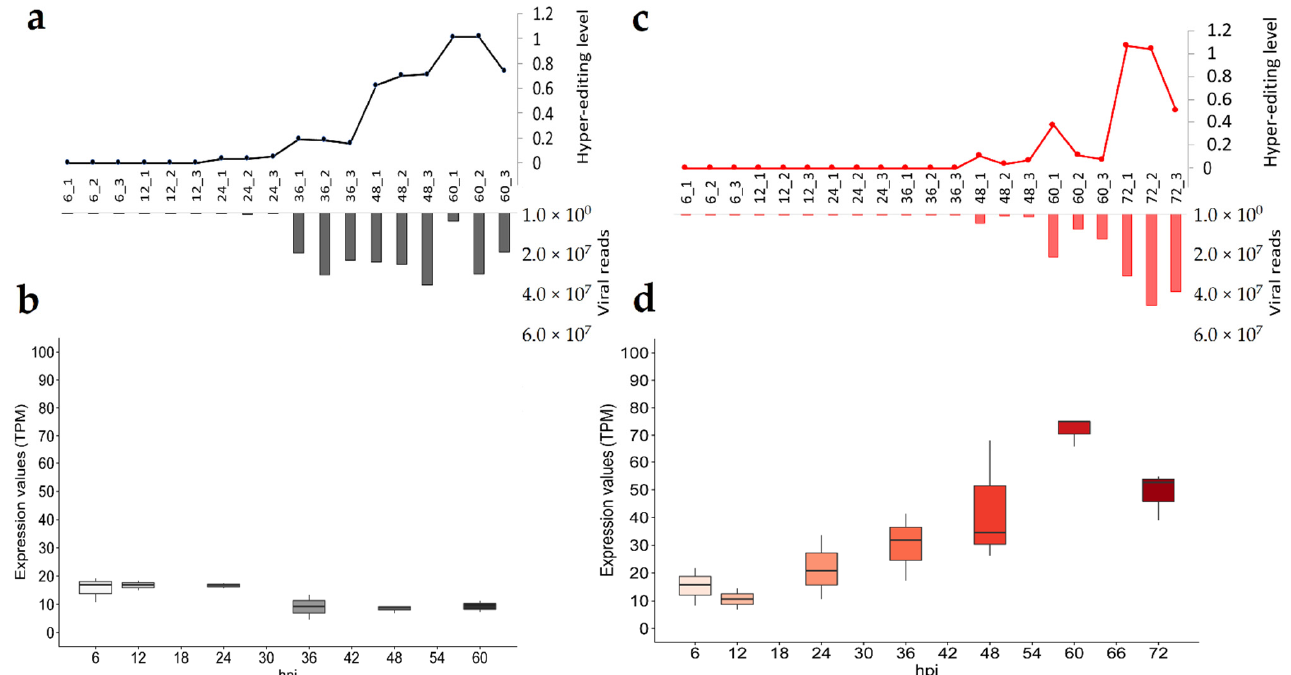
Figure 4. ADAR1 activity and expression levels during malacoherpesvirus infection. Along HaHV-1 (black data, ( a )) and OsHV-1 (red data, ( c )) infection experiments, lines represent the hyper-editing level calculated as hyper-edited reads over thousand mapped reads and bar plots represent the number of viral reads. Boxplots depict the expression of HdADAR1 ( b ) and SbADAR1 ( d ) as TPM.